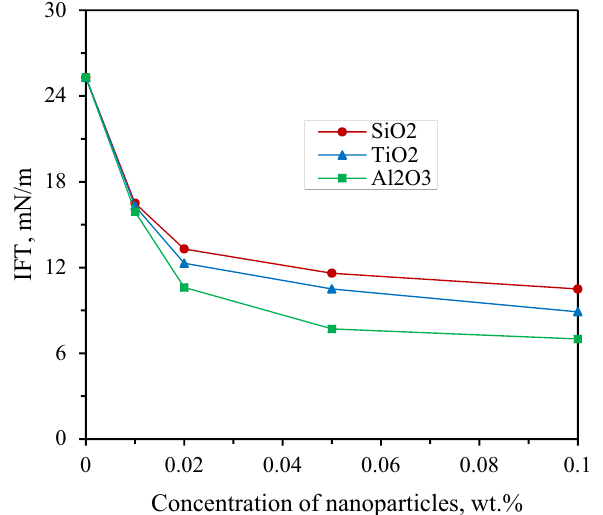
Fig. 10 The changes in IFT at various concentrations of the nanopar- ticles